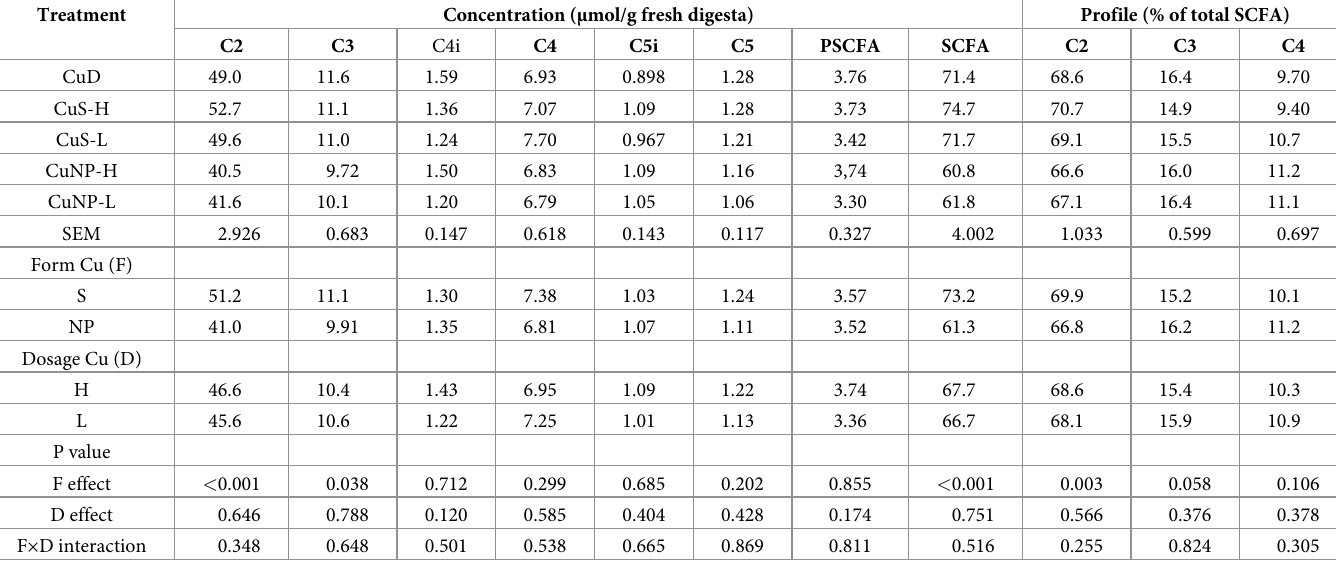
Table 10. Short-chain fatty acid (SCFA) concentration and profile in the caecal digesta of rats. Treatment Concentration (μmol/g fresh